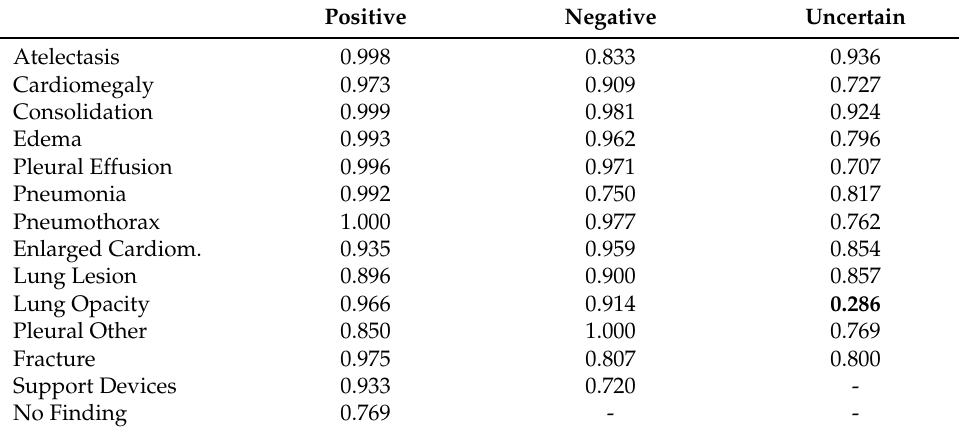
Table 2. CheXpert labeler performance on the 14 observations